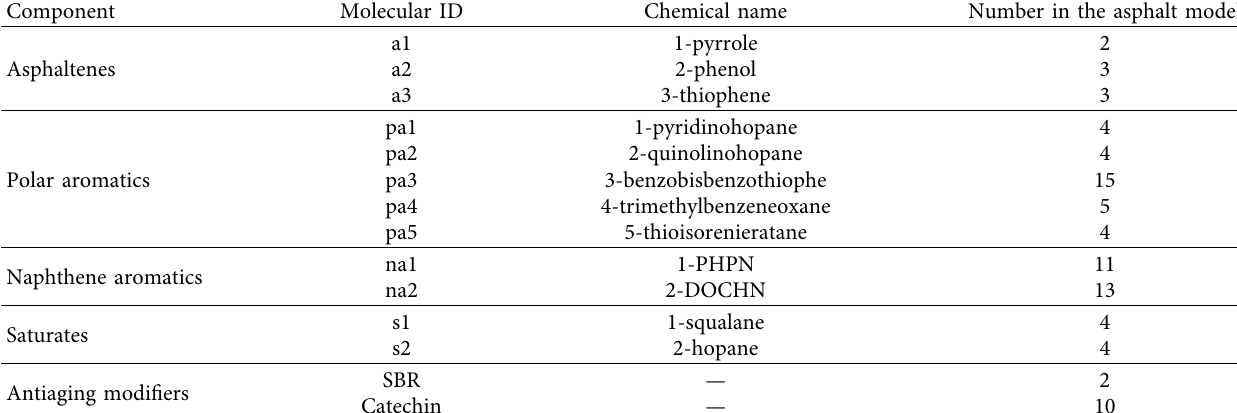
Table 1: Chemical information for molecular IDs in Figure 1 and their proportion in the asphalt model.